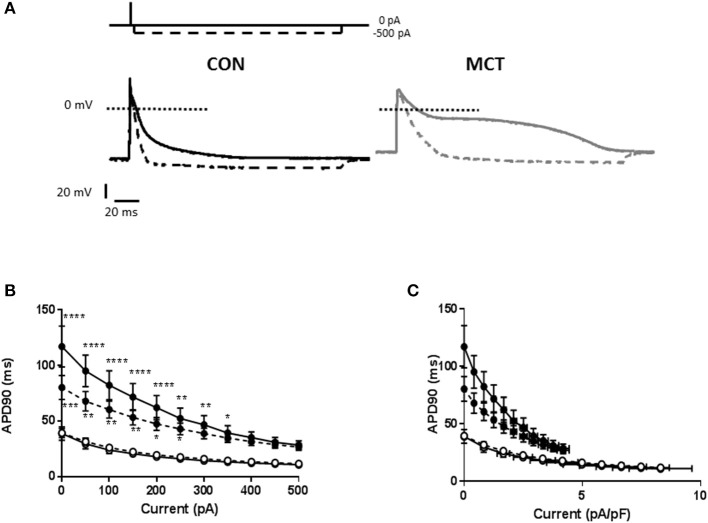
(A) Representative APs from a CON and MCT myocyte. When a 150 ms, −500 pA hyperpolarizing pulse was applied shortly after the AP upstroke, the APD was shortened (dashed line). The shortening was greater in the MCT myocyte. (B) APD90 in CON (°) and MCT (•) myocytes in the presence of hyperpolarizing pulses from 0 to −500 pA at 1 and 5 Hz (dashed lines). The shortening effect of a given current amplitude was greater in MCT myocytes than CON. Increasing stimulation frequency attenuated the shortening in MCT myocytes but had no effect in CON myocytes. (C) A similar profile of APD shortening to that described in (B) was observed when hyperpolarizing current was normalized to cell capacitance. n = 6 CON and 7 MCT myocytes ****P < 0.0001, ***P < 0.001, **P < 0.01, *P < 0.05 CON vs. MCT at the same stimulation frequency two way RM ANOVA.